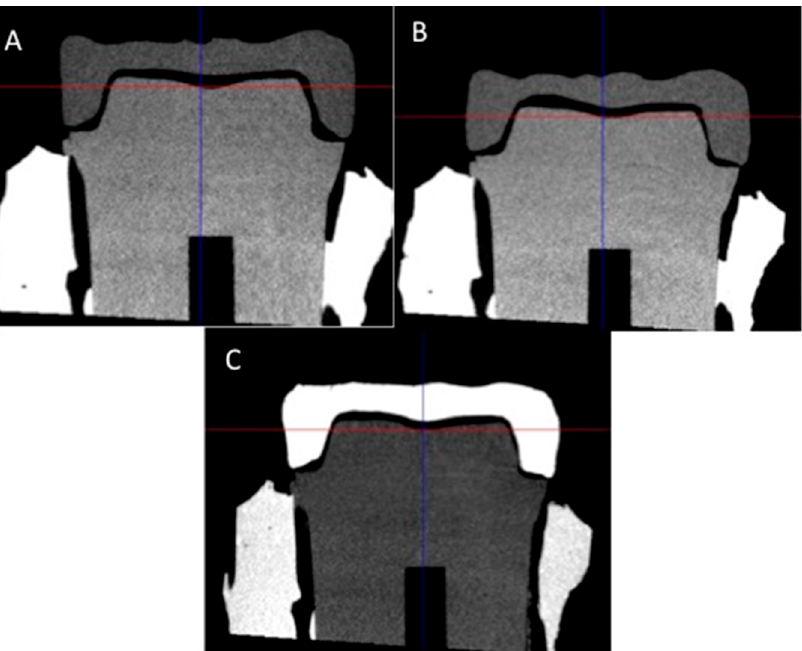
Figure 2. Micro CT images for study groups: ( A ) conventional, ( B ) CAD-CAM, and ( C ) 3D printing.